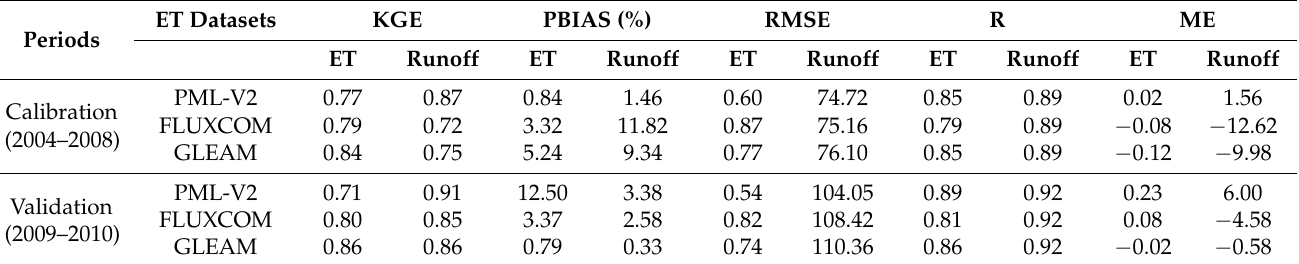
Table 4. Evaluation indices of runoff and ET simulations based on Scheme